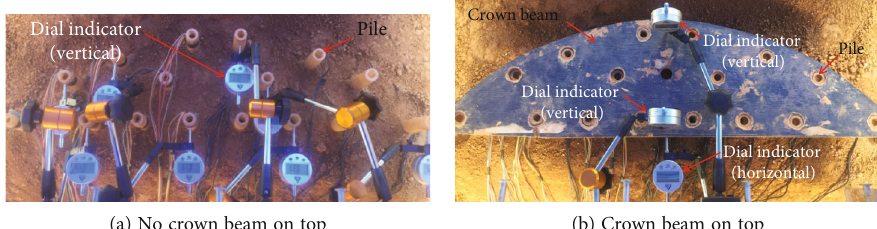
Figure 6: Actual diagram of dial indicator